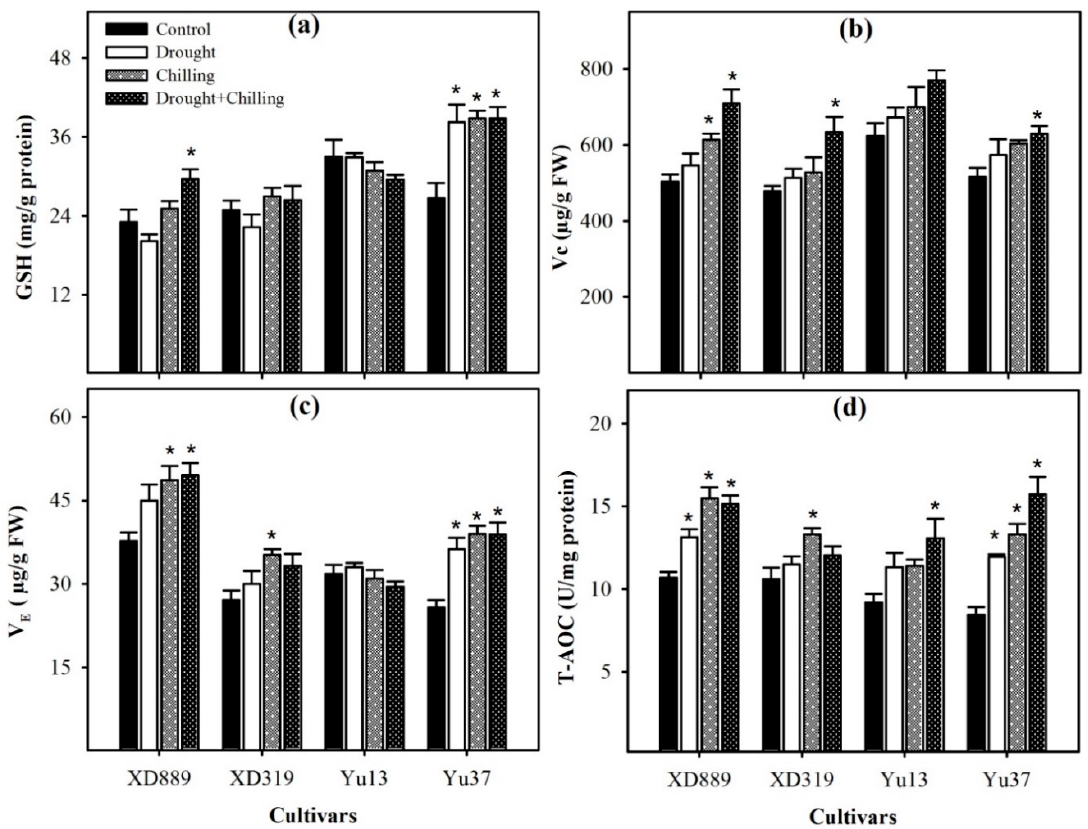
Figure 11. Levels of glutathione content ( a ), vitamin C ( b ), vitamin E ( c ), and total antioxidant capacity ( d ) in the leaves of four maize cultivars as influenced by the drought, chilling, and drought + chilling stresses. Vertical bars above mean indicate standard error of three replicates. Mean value for each treatment with * indicate significant differences compared with control according to LSD test ( P ≤ 0.05).